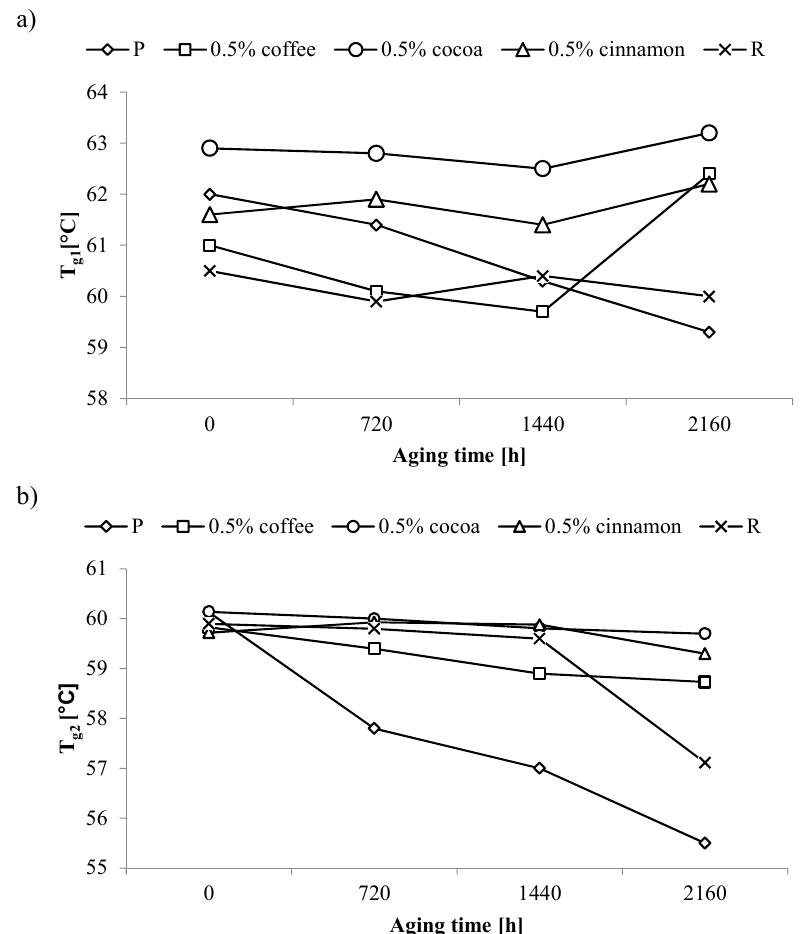
Figure 4. Changes in the glass transition temperature (T g ) of selected samples as a function of aging time; ( a ) first heating and ( b ) second heating.